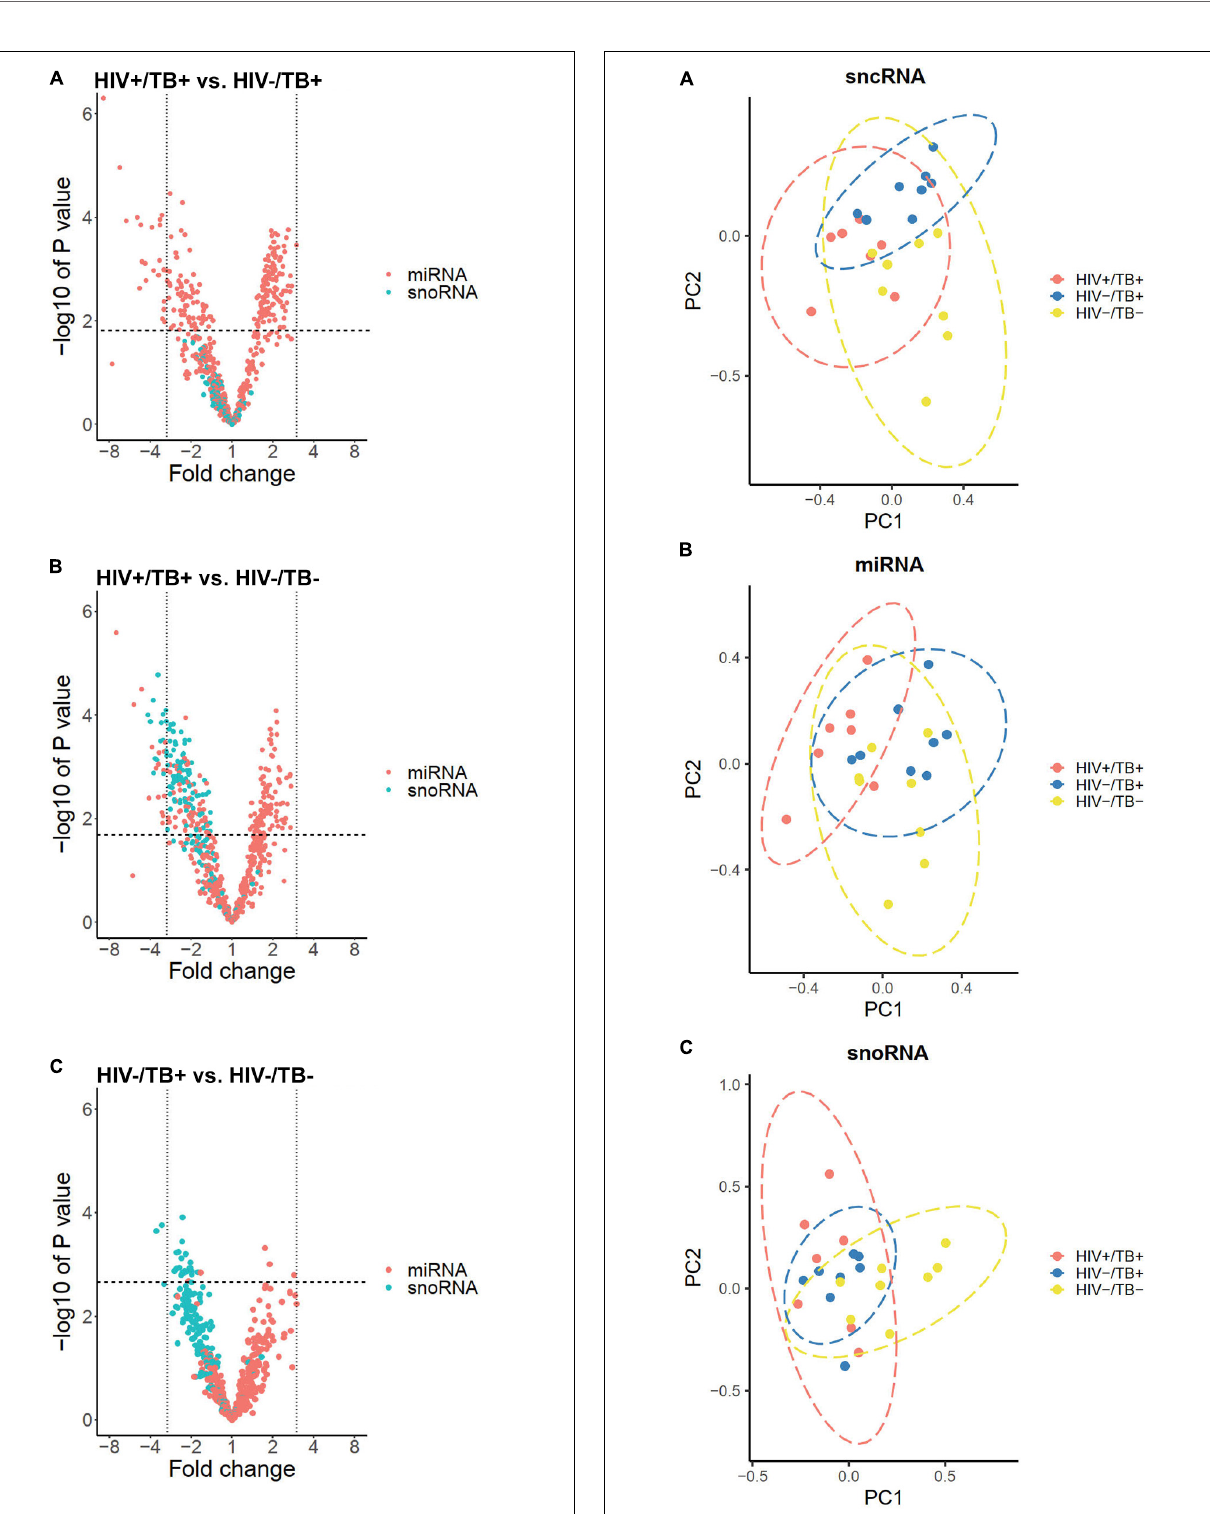
FIGURE 3 | Principal component plots illustrating clustering of the participants according to their infection status HIV+/TB+ (red), HIV-/TB+ (blue) and HIV-/TB- (yellow) based on (A) all sncRNAs (B) miRNAs (C) snoRNAs. Data ellipses calculated based on the t-statistic with 95% confidence intervals. Microarray data were median centered before